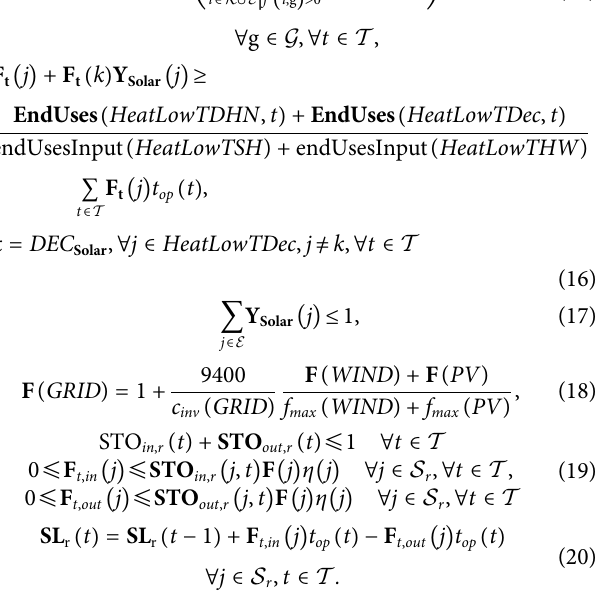
TABLE 1 | Storage cost, summarized from Gorre et al. (2018) and Leeuwen and Zauner (2018). Storage